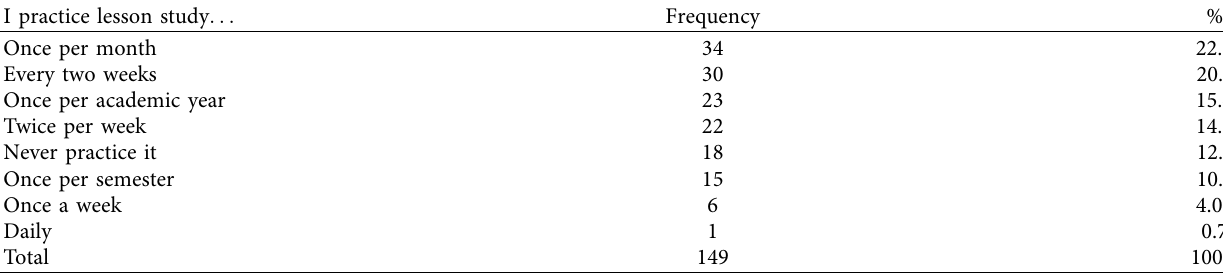
Table 3: Frequency of practicing lesson study.